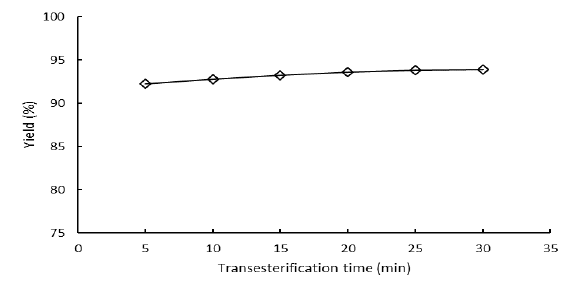
Figure 5: The effect of transesterification time to yield of biodiesel (microwave power at 450 W and catalyst concentration of